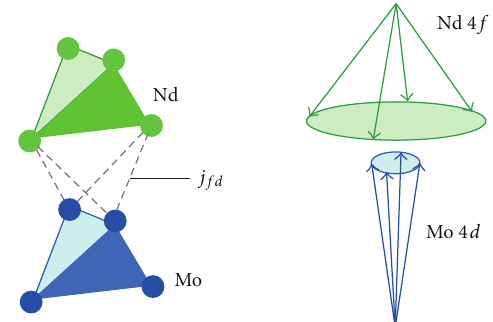
Figure 4: Left: the crystal structure of Nd 2 Mo 2 O 7 is made up of Mo and Nd tetrahedra. At 10 K the spin chirality of the magnetic order on the Nd tetrahedra is transferred to the Mo tetrahedra via the J fd exchange interaction. Right: the magnetic structures of the Nd and Mo tetrahedra form antiparallel “umbrellas”. Figure taken from